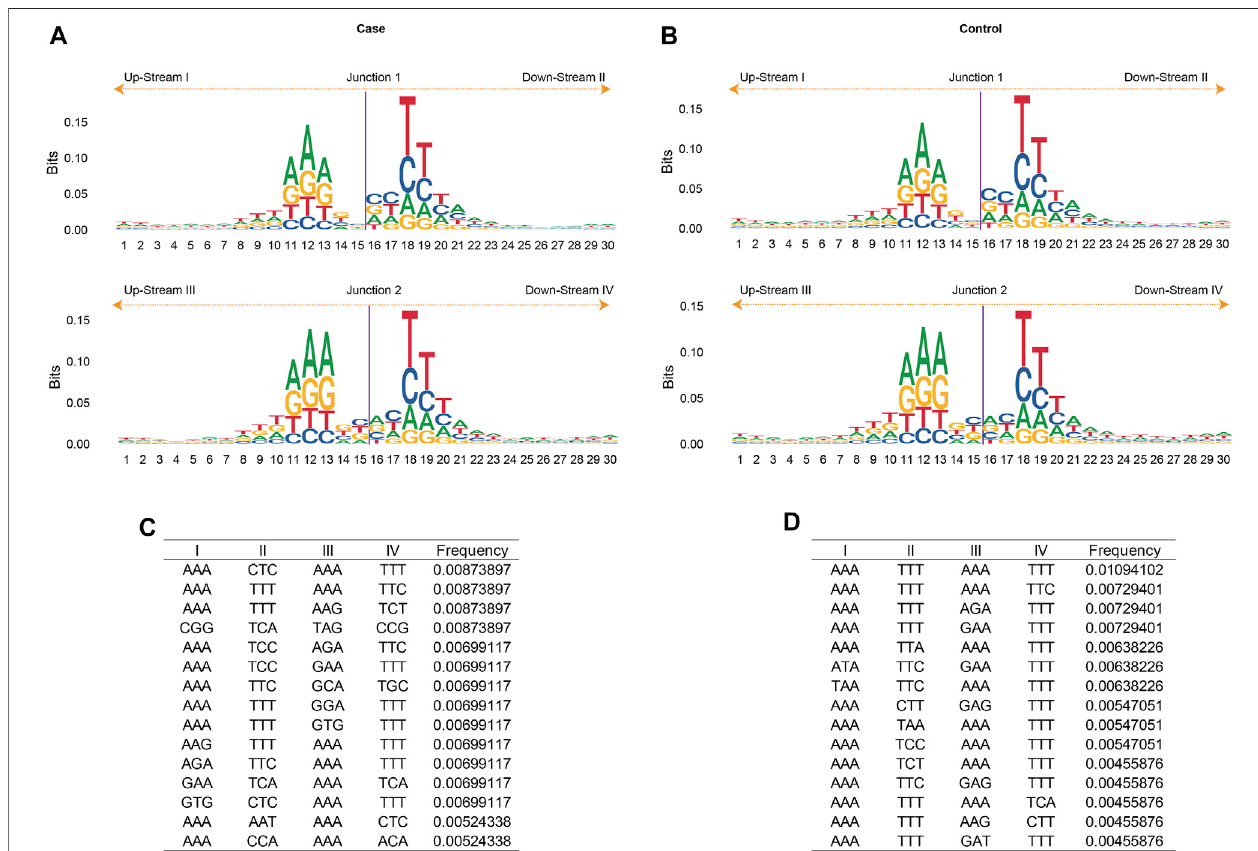
FIGURE 4 | The motif analysis of eccDNA junctions. The nucleotide composition from 15 bp upstream to 15 bp downstream of the start (Junction 1) and end position (Junction 2) of the eccDNA junction in acute gout (A) and healthy control (B) . The frequency of base distribution at each position is plotted as a stacked histogram.Thesizeoffourbasesateachpositioninthe fi gurere fl ectstheirfrequency.The3-bpmotifs fl ankingthestartandendsiteinacutegout (C) andhealthycontrol (D) . Data were ranked by motif frequencies. I, II, III, IV refers to 3-bp upstream of start site, 3-bp downstream of start site, 3-bp upstream of end site, and 3-bp downstream of end site,